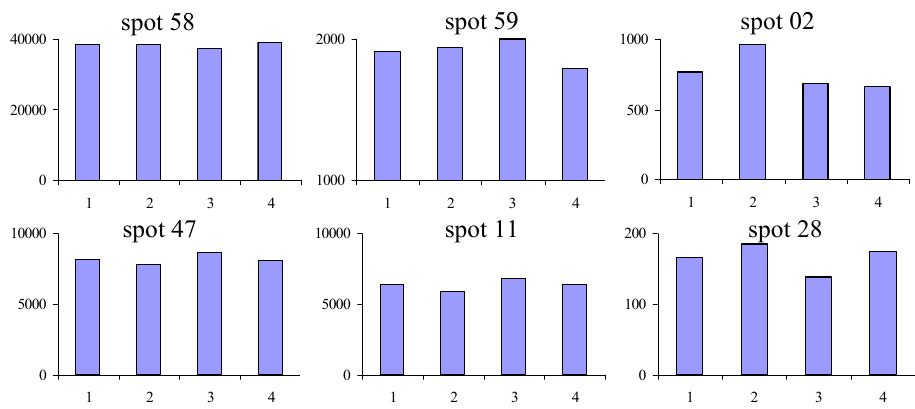
Figure 3. Comparison of spot intensities from biological